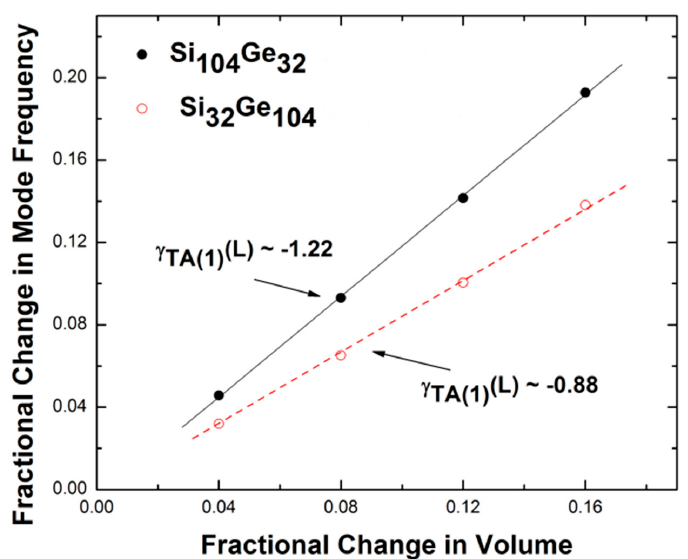
Figure 6. Variation in the fractional change in the mode frequency with respect to the TA(1) phonon branch along the Γ -L direction, as a function of the fractional change in the volume.